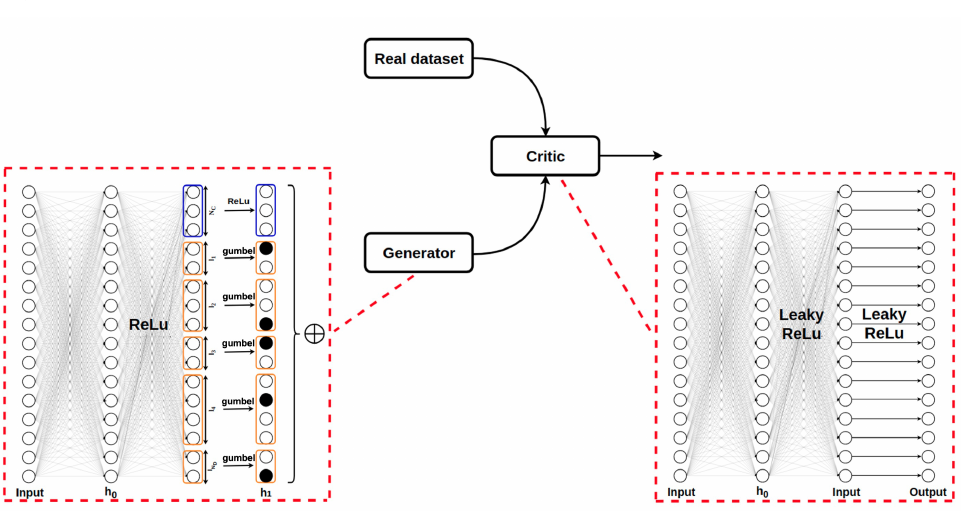
Figure 1. Model architecture. The generator consists of an initial fully connected layer with ReLu activation function, and a second layer which uses ReLu for numerical attributes generation and gumbel-softmax to form one-hot representations of categorical attributes. The final data are then produced by concatenating all attributes in the last layer of the generator. The critic consists of fully-connected layers with LeakyReLu activation